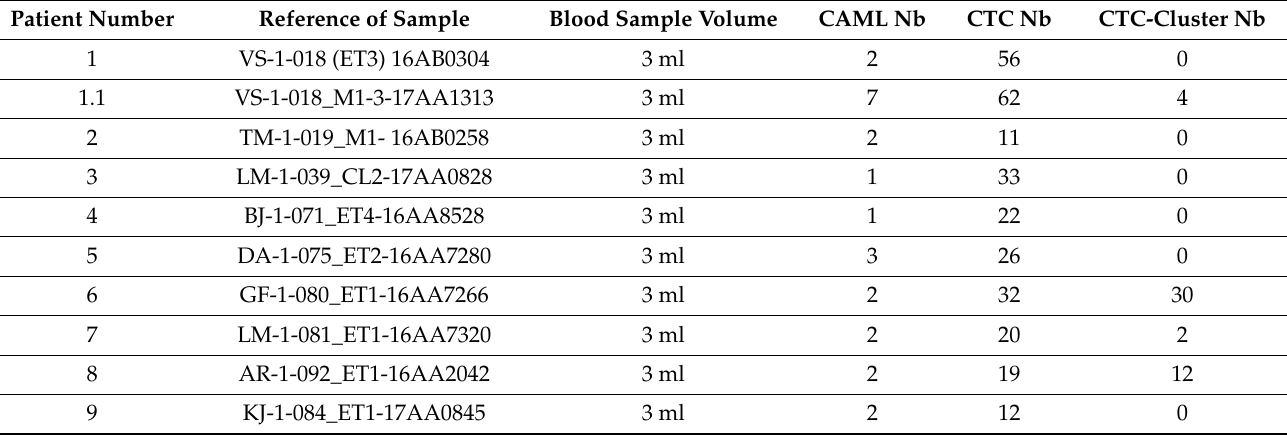
Table 1. Results of enumeration of CAMLs, CTCs, and clusters in 10 melanoma blood